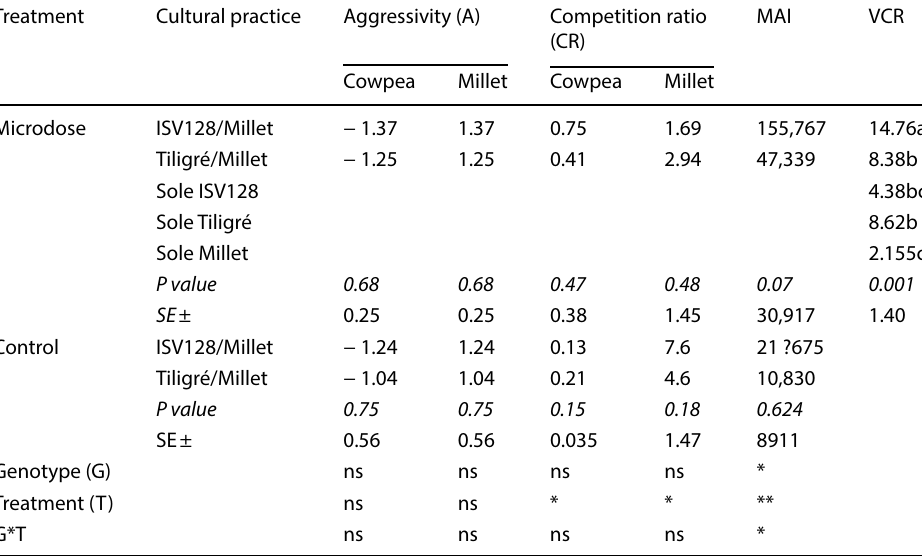
Table 6 Competition index of combined cowpea millet and economic advantage under microdose fertilizer and intercropping in combined crop and sole crop in